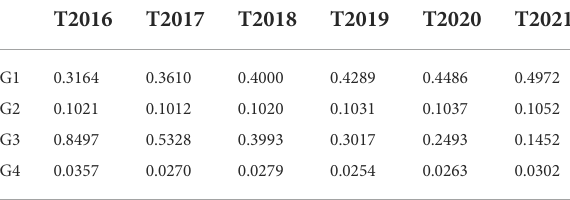
TABLE 1 Spatial Gini coef fi cient of new energy industry in Zhejiang